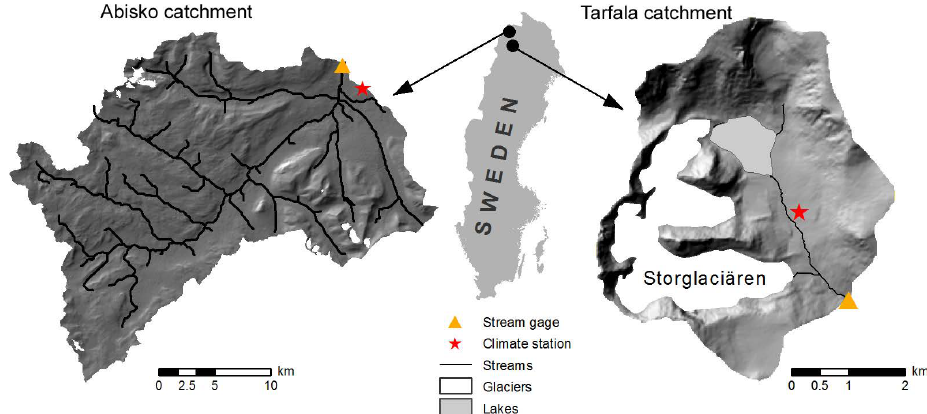
Fig. 1. Site map showing the Abisko and Tarfala catchments in northern Sweden. Triangles and stars indicate locations of stream gauges and rain gauges, respectively. Note the different scales of the catchment